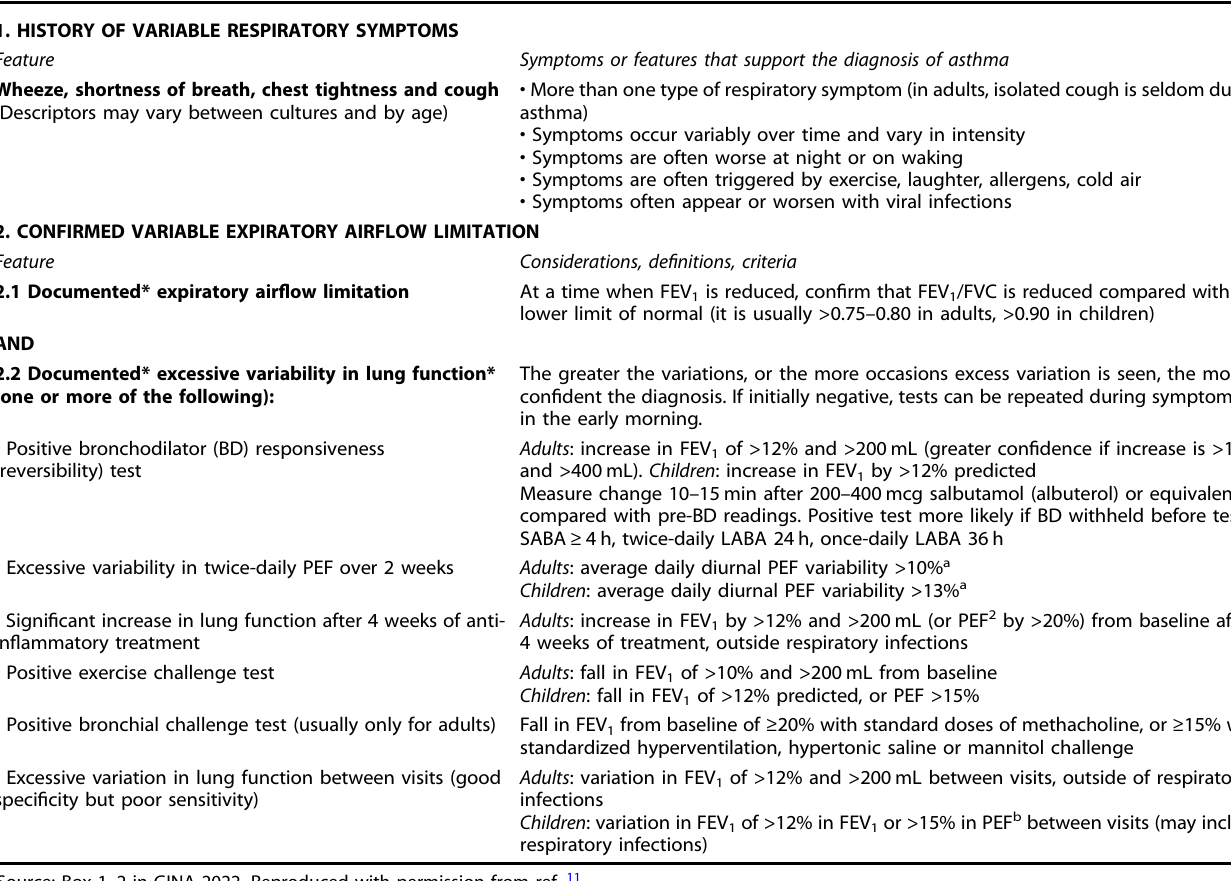
Table 2. Diagnostic criteria for asthma in adults, adolescents, and children 6 – 11